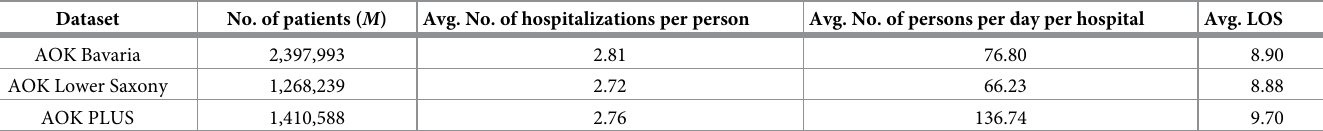
Table 3. Basic description of AOK patient characteristics.